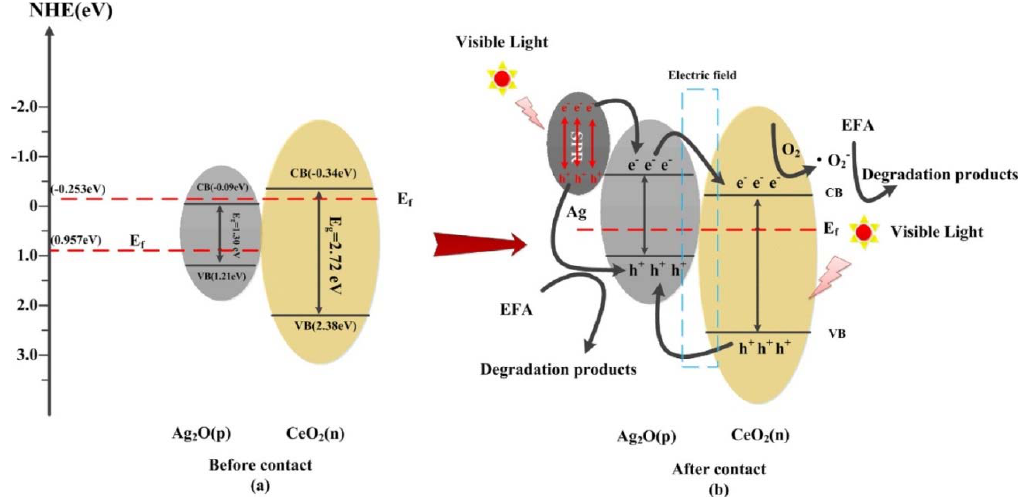
Figure 18. The proposed mechanism for the enhancement of photocatalytic activity of Ag 2 O/CeO 2 catalyst in degradation of enrofloxacin. Reproduced from Ref. [167] with the permission from the Elsevier.